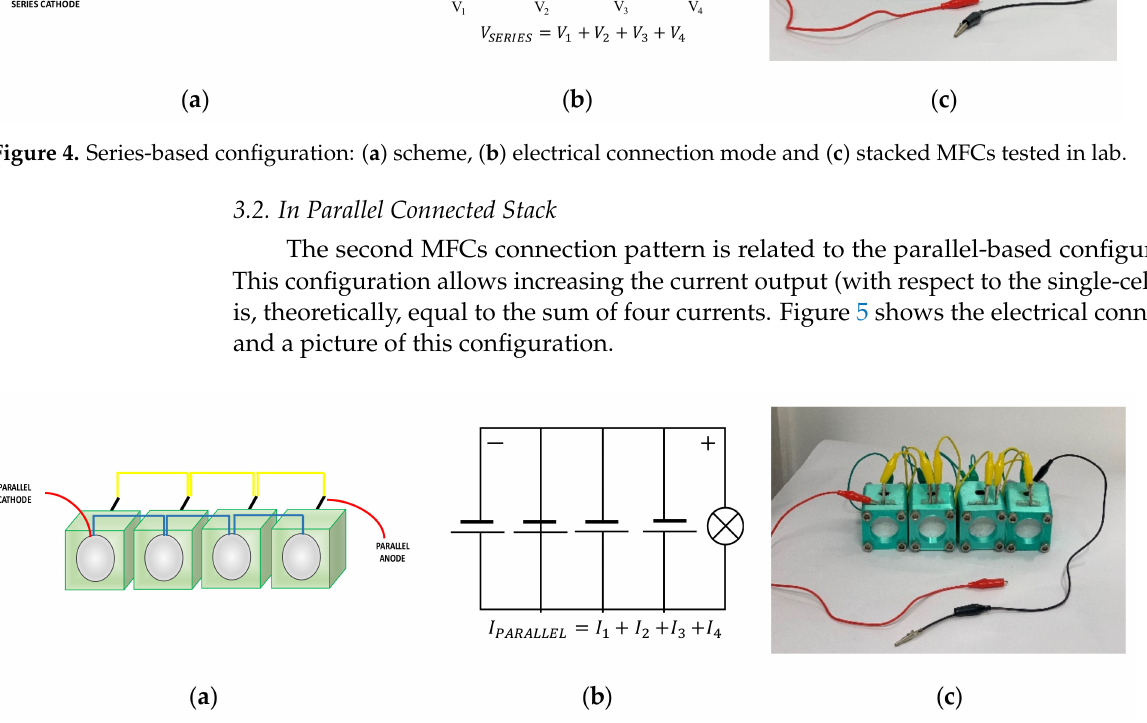
Figure 5. Parallel-based configuration: ( a ) scheme, ( b ) electrical connection mode and ( c ) stacked MFCs tested in lab.